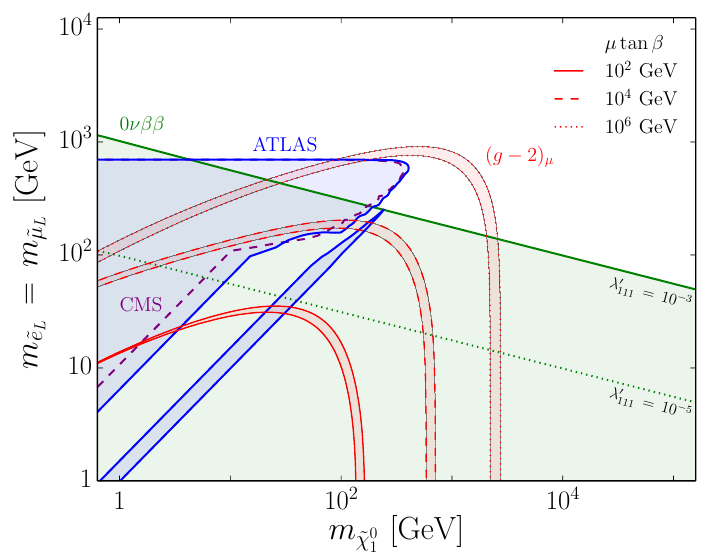
Figure 8 . The constraints from 0 νββ decay and ATLAS and CMS in the ( λ 0 compared to the favoured regions suggested by the ( g − 2) µ anomaly for different values of the MSSM parameter combination µ tan β